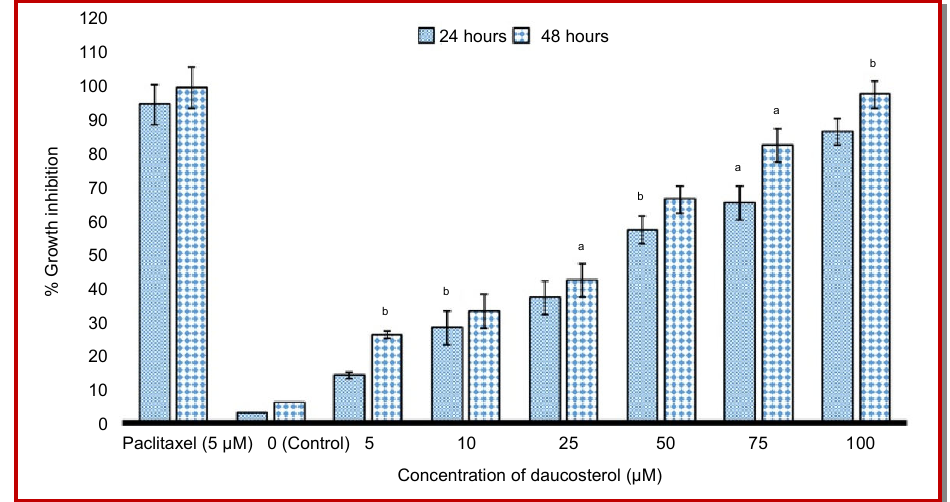
Figure 2: Cytotoxic effect of daucosterol in human colon cancer cells (HCT-116) at different doses. Data are shown as the mean ±